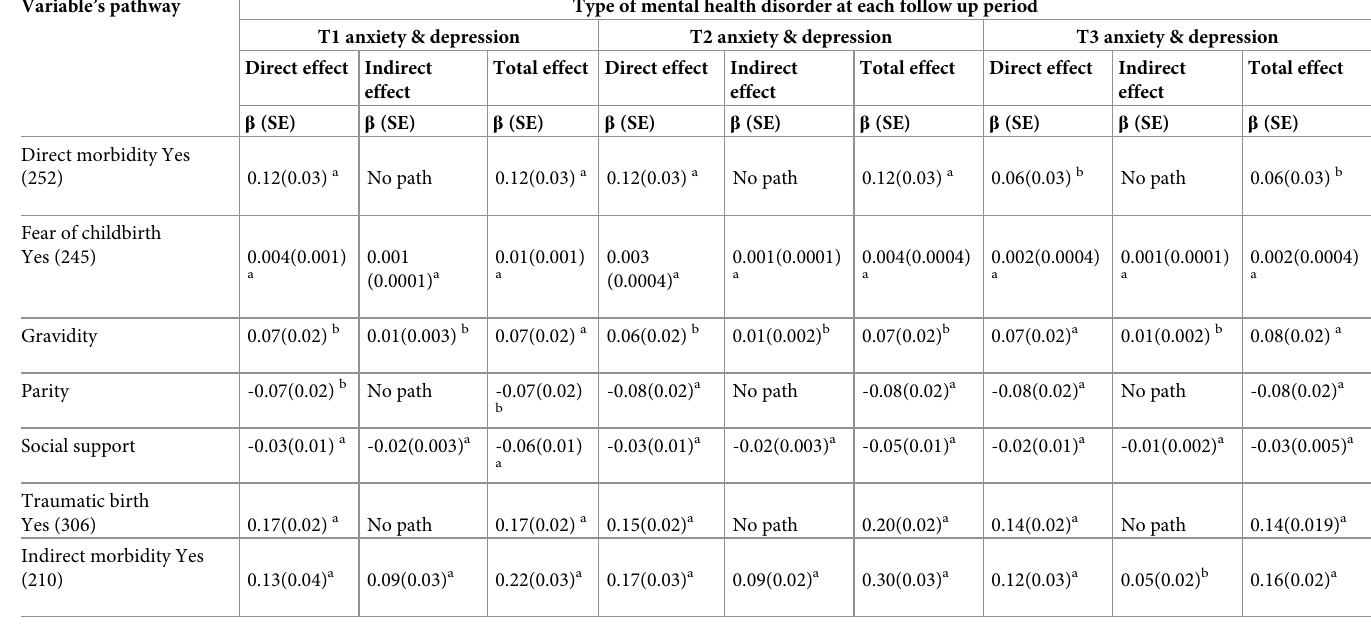
Table 5. Direct, Indirect and total effects of variables associated with comorbidity of depression with anxiety, among postpartum women in Northwest Ethiopia, 2021. Variable’s